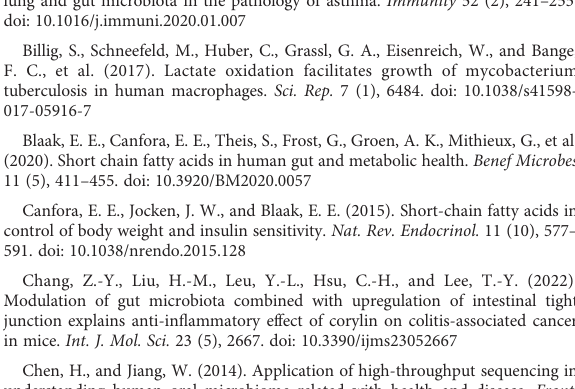
SUPPLEMENTARY FIGURE 1 The interaction network of intestinal fl ora in HCs and PTB patients. The interaction network of intestinal fl ora in HCs showed a simple relationship between the community members, and the interaction network of intestinal fl ora in PTBs had more positive and negative correlations among the bacteria. The correlation coef fi cients were calculated with the Sparse Correlations for Compositional (SparCC) data algorithm. Cytoscape version 3.4.0 was used for network